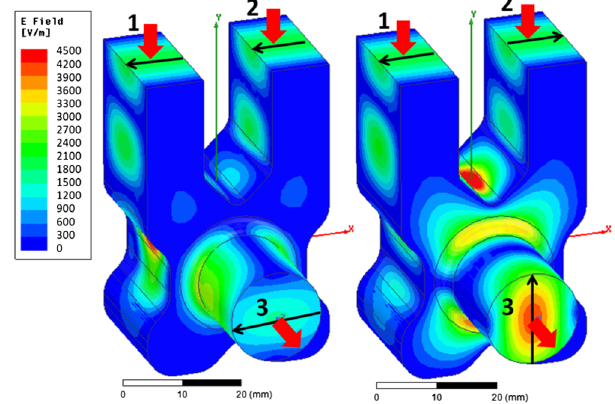
FIG. 6. E-rotator geometry and electric field distribution for 1 Wof total input power into port 1 and 2 with the same (left) and with the opposite phase (right). The black arrows in the ports 1 and 2 indicate the rf phase. The black arrows in the output port show the polarization of the linear TE 11 mode.